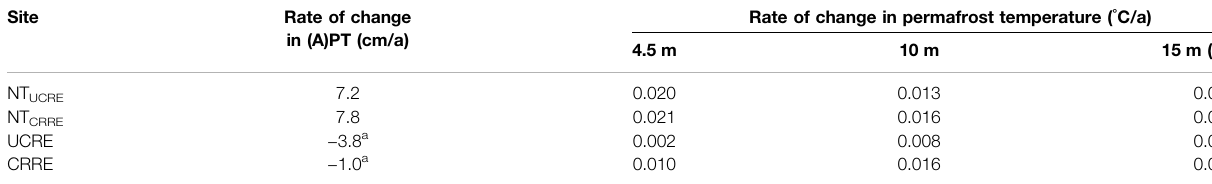
TABLE 1 | Rate of change in the (A)PT and ground temperature at different depths beneath natural sites and embankment from 2006 to 2018. Site Rate of change Rate of change in permafrost temperature ( ° C/a) in (A)PT (cm/a)